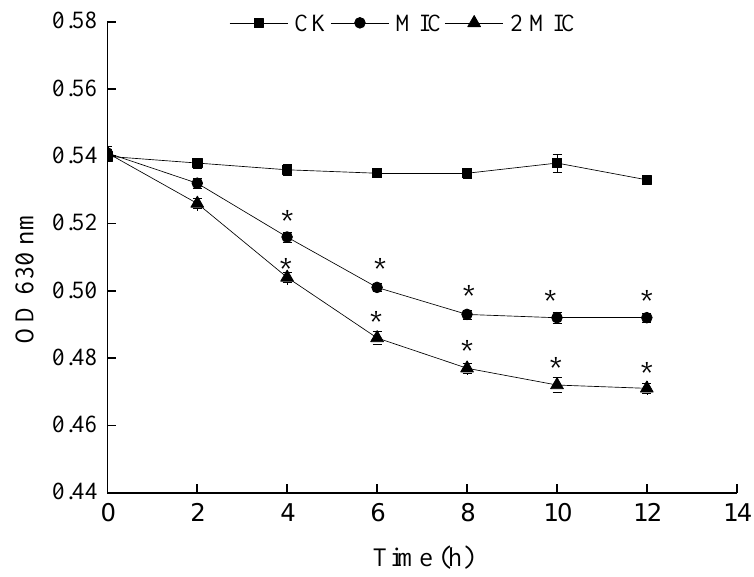
Figure 8. Effects of ε-PL on cell metabolism of S. putrefaciens . Bars represent the standard error of the means. The superscript (*) indicates a result that is significantly different to the equivalent control point (t test, p < 0.05 ).